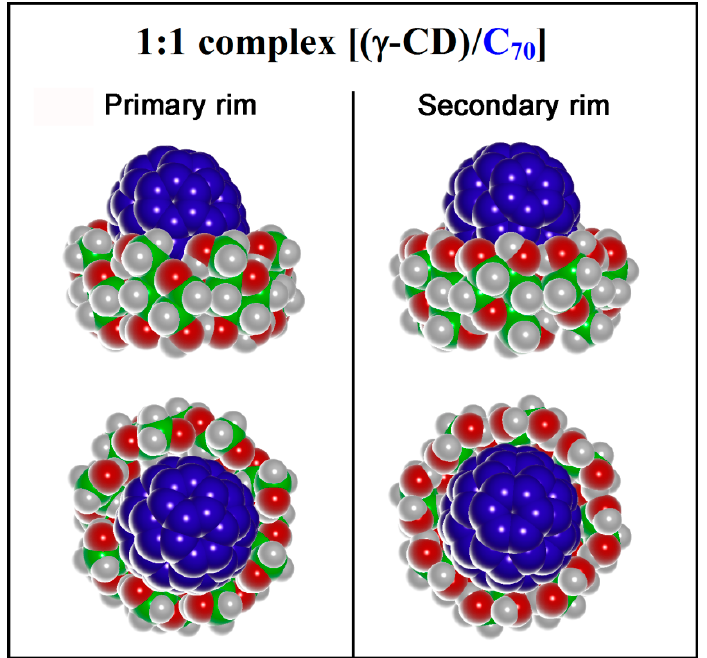
Figure 2. Side view and top view of the 1:1 complex [( γ -CD) / C 70 ] formed by C 70 with γ -CD in vacuo at the primary rim and at the secondary rim, in the most stable geometry found after MM and MD calculations. The γ -CDs are colored by atoms (C atoms are green, and O atoms are red, H atoms are in white, and the C 70 atoms in blue).